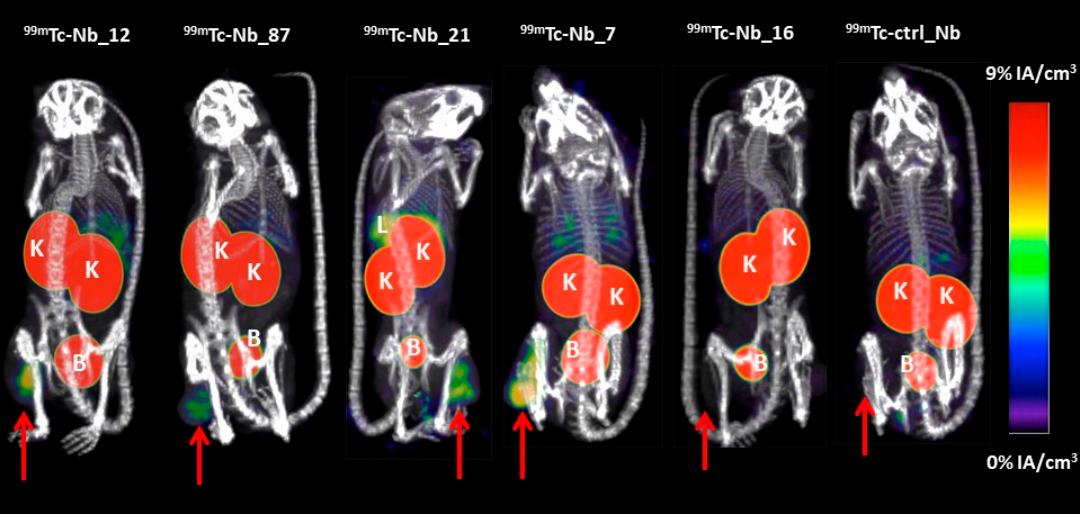
Table 3. Ex-vivo biodistribution of 99m Tc-Nbs in mice bearing THP-1 tumors. Nb_7 Nb_12 Nb_16 Nb_21